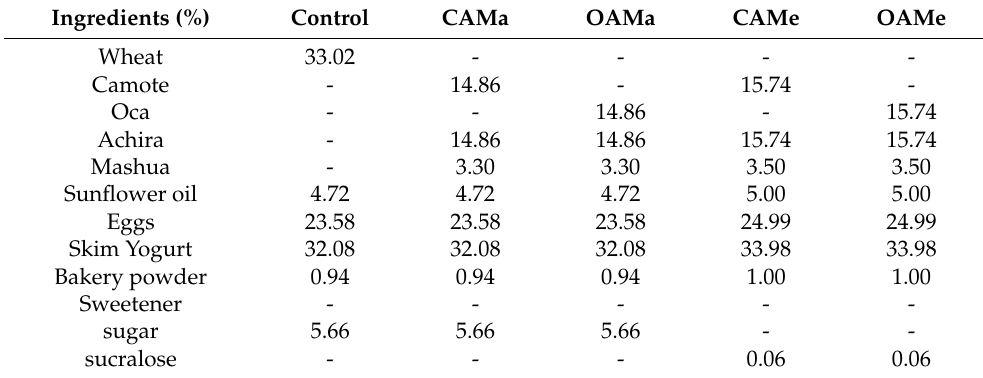
Table 1. Muffin formulations prepared with Andean crops flours